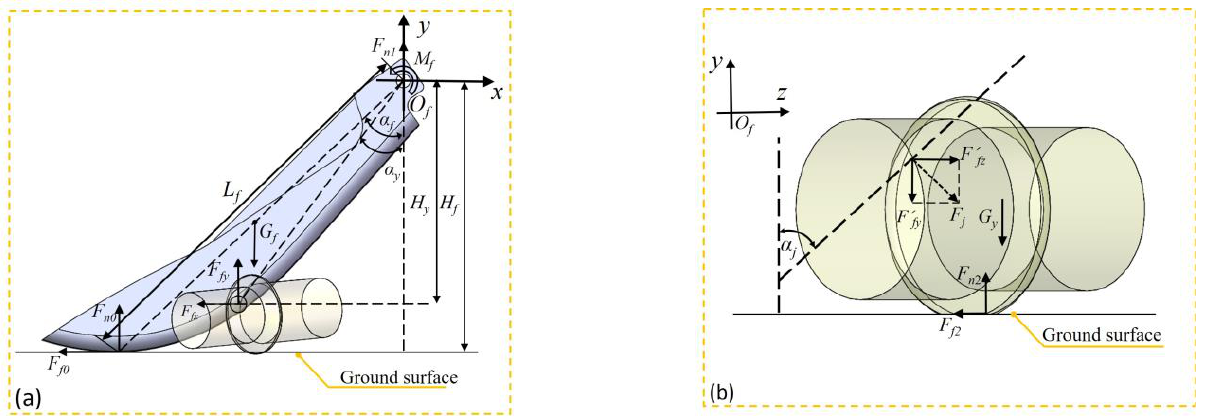
Figure 6. ( a ) Force analysis of profiling plate. ( b ) Force analysis of corn straw. During machine operation, the profiling effect of the profiling plate is affected by the straw on the ground surface. If the torque applied at fixed shaft is not enough to make the profiling plate attach to the ground surface, the accuracy of control system information detection will be affected. In order to eliminate the influence of the straw on the profiling effect, the component force of profiling plate on the corn straw along z axis should be greater than the friction force of ground surface against straw. When the contact between the profiling plate and the ground surface is in a critical position status due to the action of straw, as shown in Figure 6b, Equation (4) can be obtained by the force analysis of straw in the yo f z plane.